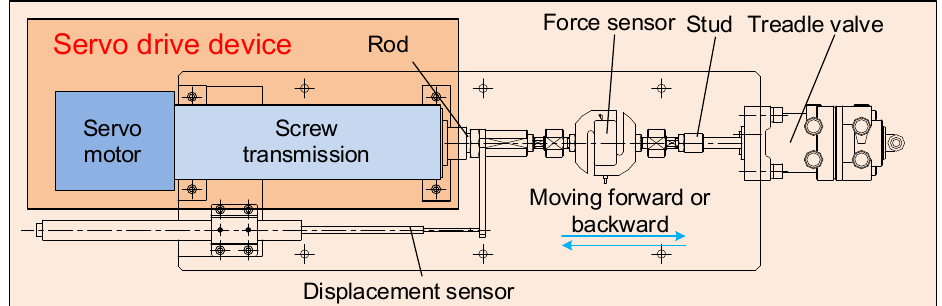
Figure 5. A servo drive device used for simulating driver’s braking intensions.